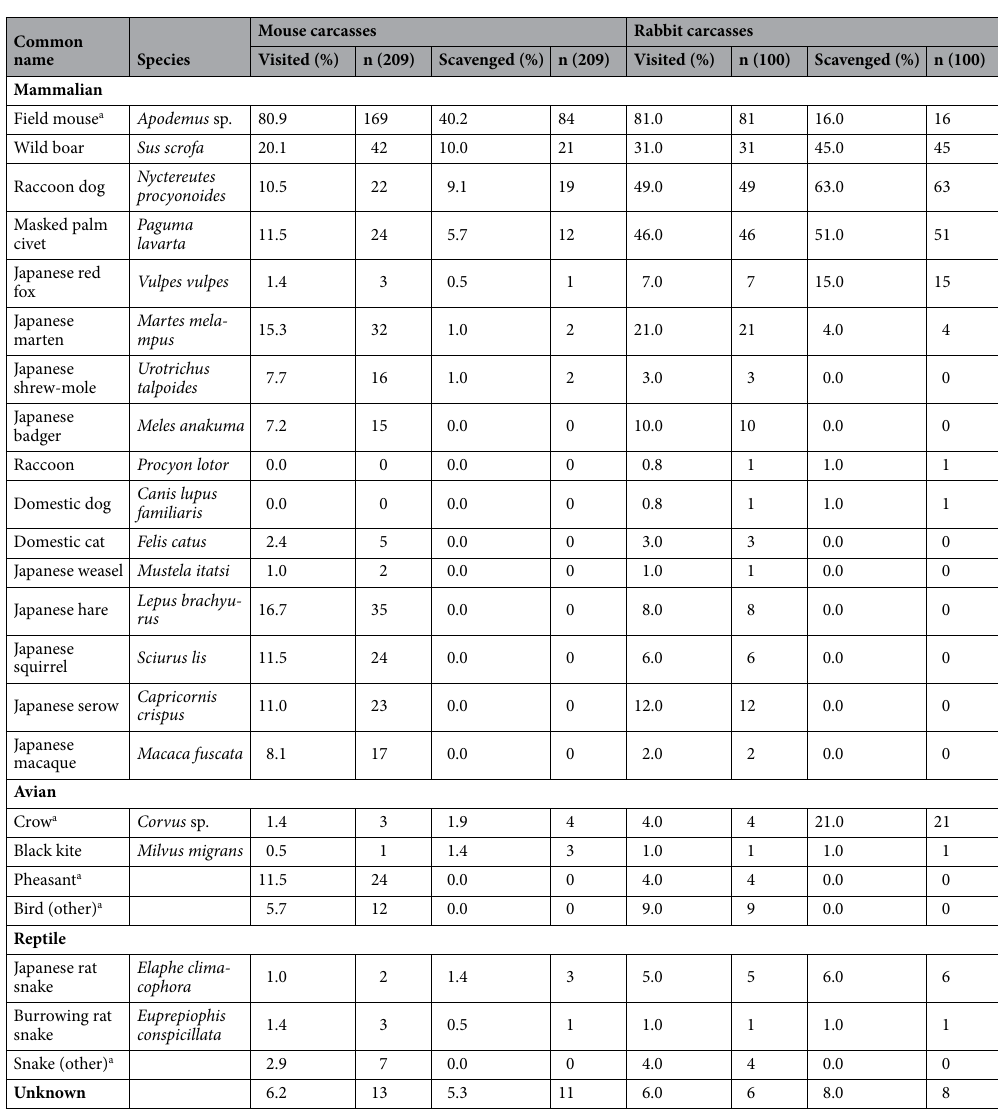
Table 1. Proportion of all experimentally placed carcasses (n = 309) visited and scavenged by all species across both carcass sizes (mice, rabbits) in Fukushima, Japan from May to July 2018, including trials from both the Fukushima Exclusion Zone (FEZ) and inhabited reference area. a Not identified to